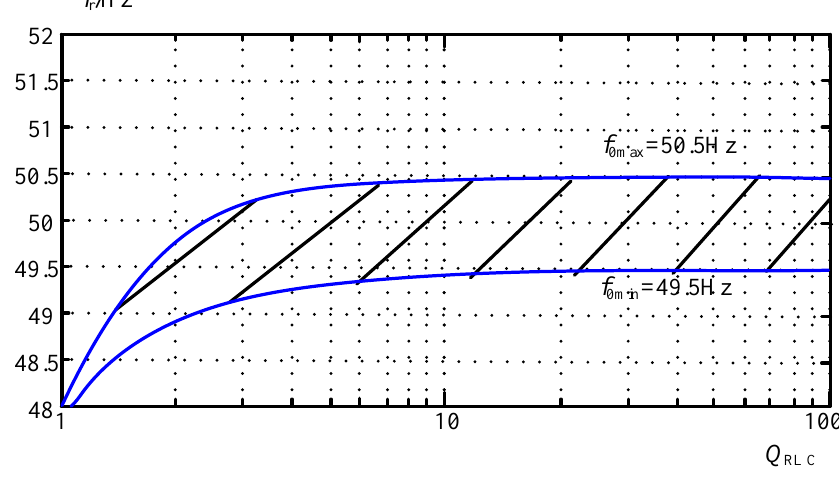
Figure 6. The non-detection zone (NDZ) of the islanding detection method.